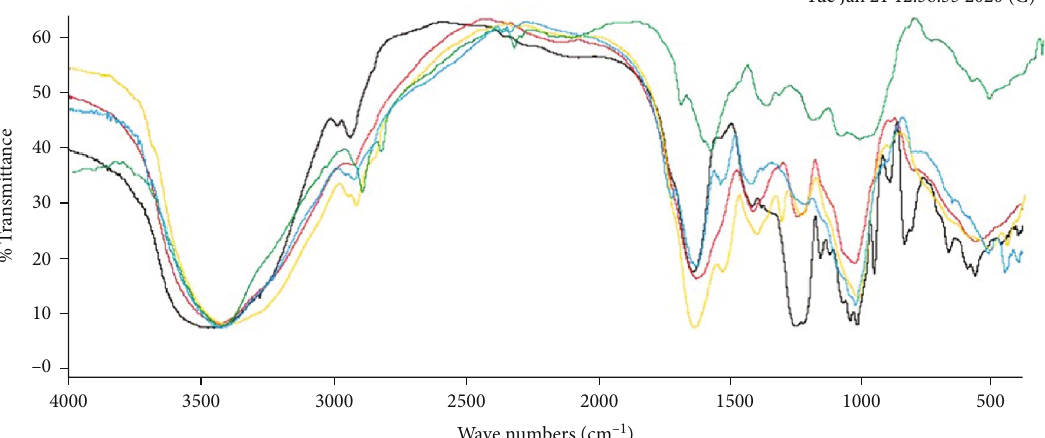
Figure 2: FT-IR spectra of fucoidan from S. hystrix (method A: blue line; method B: green line; method C: red line; method D: yellow line) and commercial fucoidan M. pyrifera (black